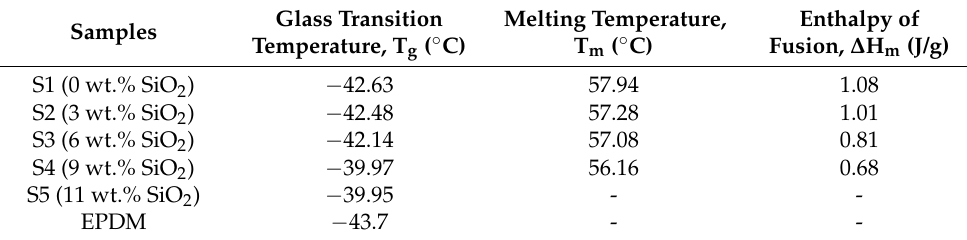
Table 2. Thermal behavior of neat EPDM and EPDM-based MRE samples.